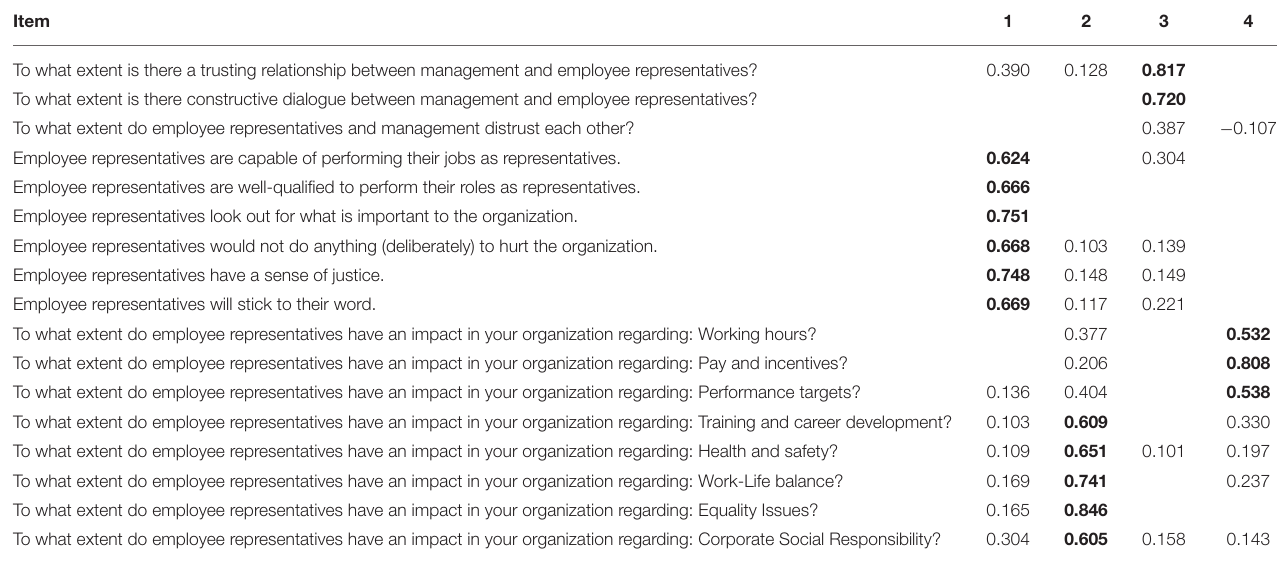
TABLE 1 | Rotation factor matrix. Item